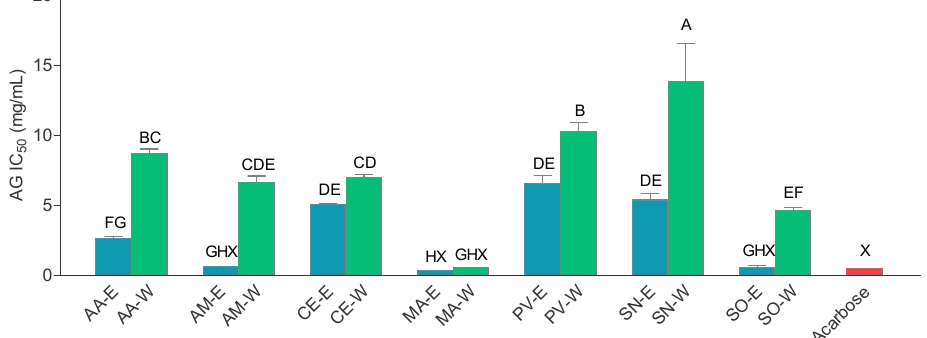
Figure 2. α -glucosidase inhibitory activity (AG IC 50 ) of the extracts. The extracts’ abbreviations are presented in Table 2. Values are average of 3 replications ± SD; A–H = differences between the extracts within a column (extracts not connected with the same capital letter are statistically different, Tukey post-test, p < 0.05); X = differences with the positive control within a column (extracts not connected with the same capital letter are statistically different, Dunnet’s post-test, p < 0.05).